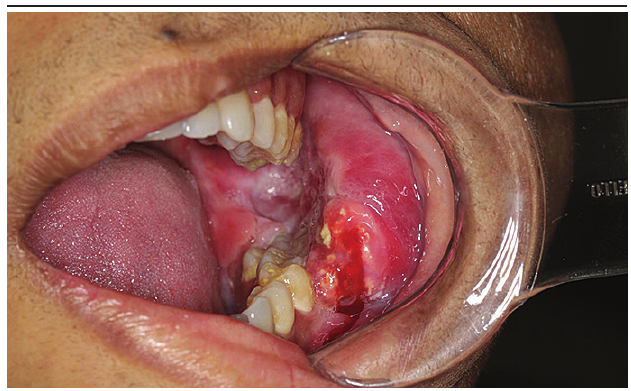
FigurE 5 − Intraoral photography, showing volume increase with presence of leukoerythroplastic lining mucosa with ulcerated